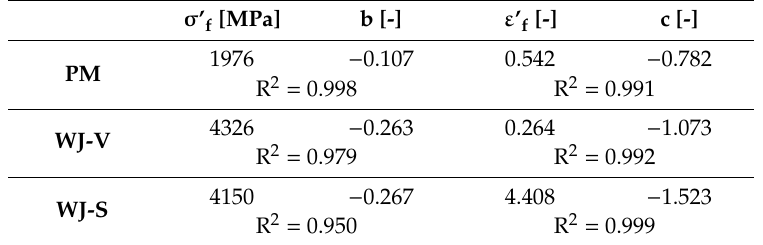
Table 3. Fatigue properties of examined HSS steel and two types of welded joints.